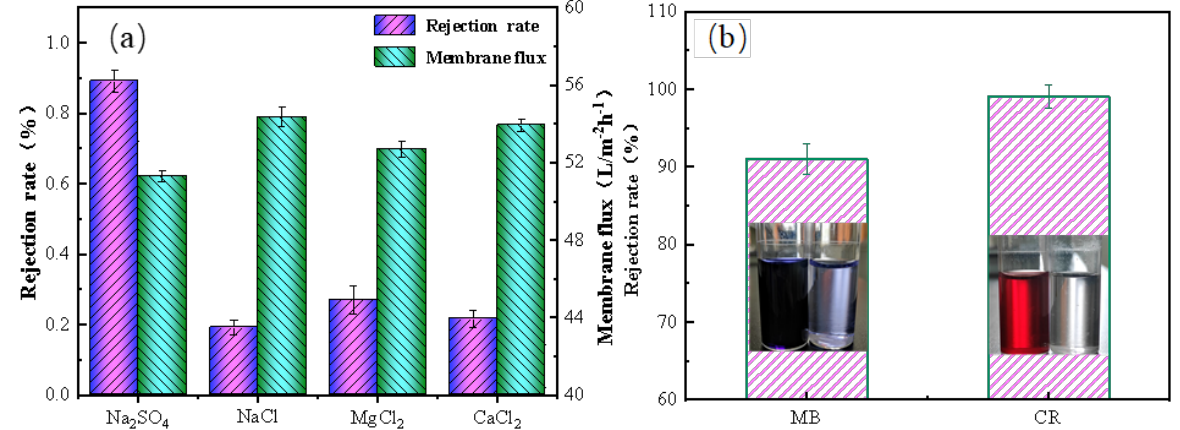
Figure 15. ( a ) Interception of inorganic salt solution by ZrO 2 /BC − NFM; ( b ) interception of dye by ZrO 2 /BC − NFM.